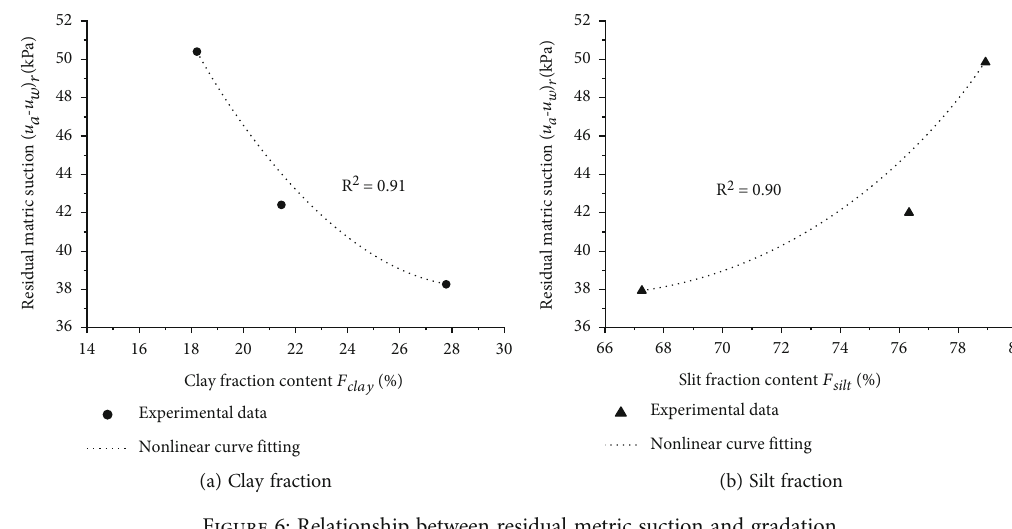
Figure 6: Relationship between residual metric suction and gradation. Table 3: Soil sample with di ff erent clay mineral contents. Serial number Montmorillonite